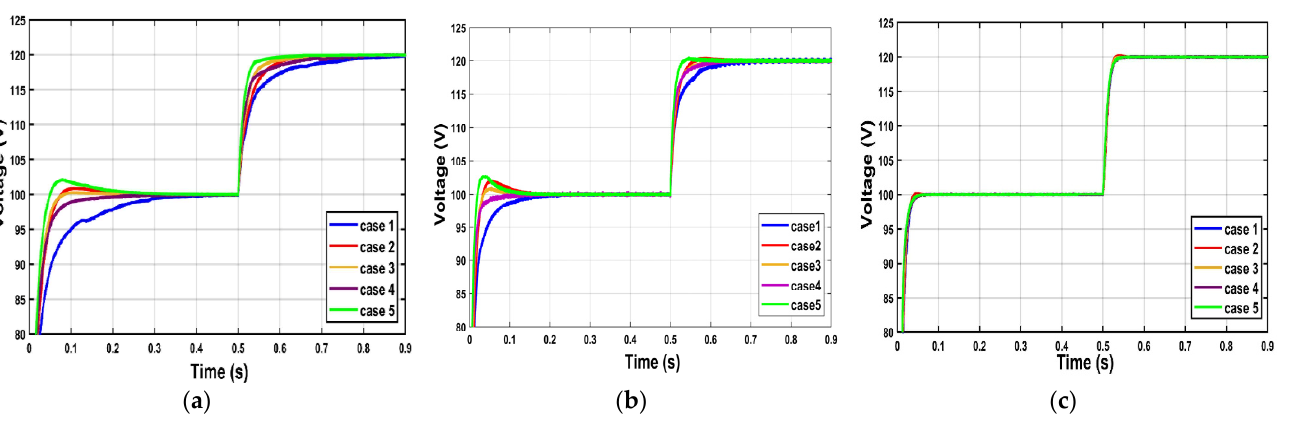
Figure 7. Output voltage response for different voltage reference.